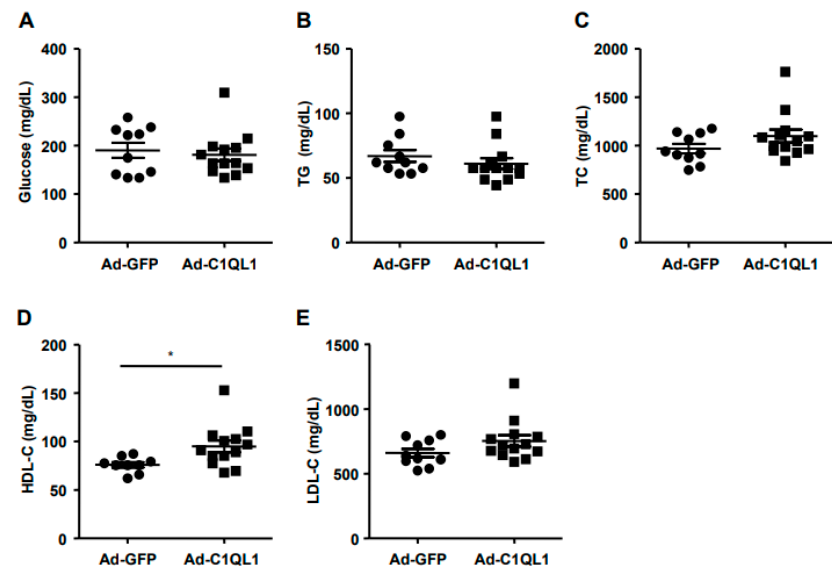
Figure 4. Plasma levels of glucose ( A ), TG ( B ), TC ( C ), HDL-C ( D ) and LDL-C ( E ). Data are presented as the mean ± SEM. n = 10 or 15 for each cohort. * p < 0.05, Ad-C1QL1 versus Ad-GFP. TG, triglyceride; TC, total cholesterol; HDL-C, high density lipoprotein cholesterol; LDL-C, low density lipoprotein cholesterol.